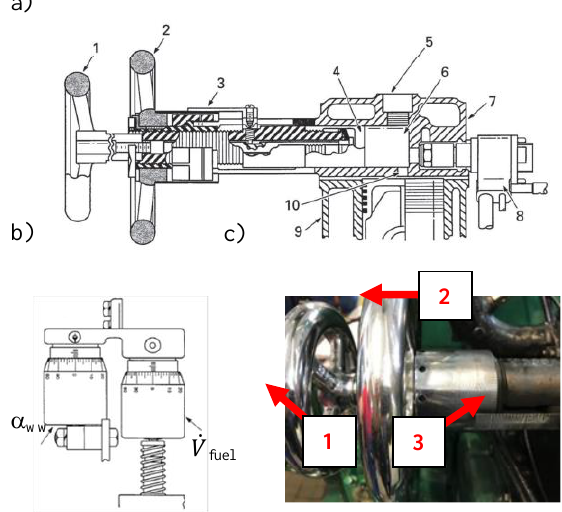
Fig. 5. Components of the CFR F5 test engine’s control system: a) cylinder head assembly with adjustment of the pre-combustion chamber